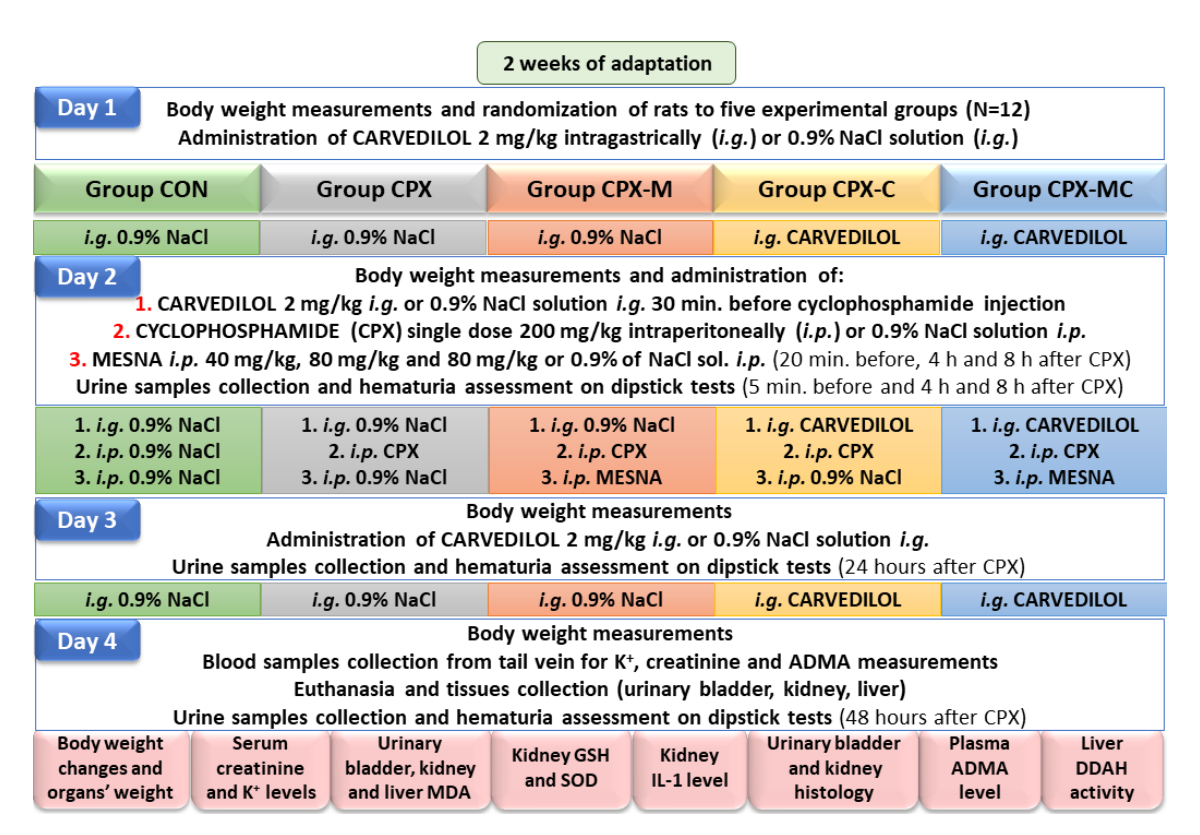
Figure 9. The general organization of the experiment.